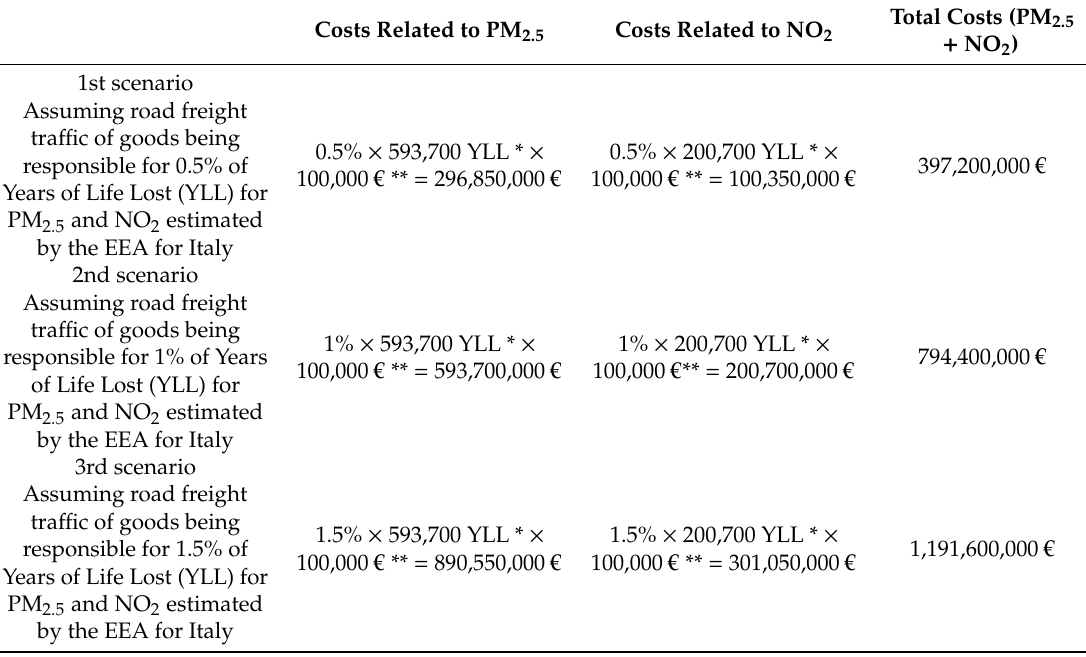
Table 1. Health costs attributable to road freight tra ffi c of